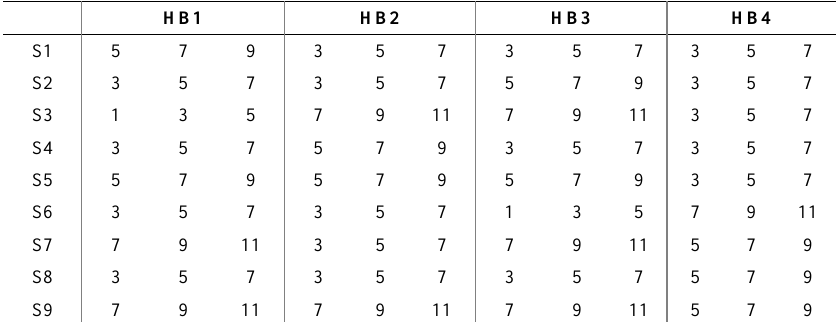
Table 9. Fuzzy Strategy Matrix toward Barriers in Process/Business Criteria from One